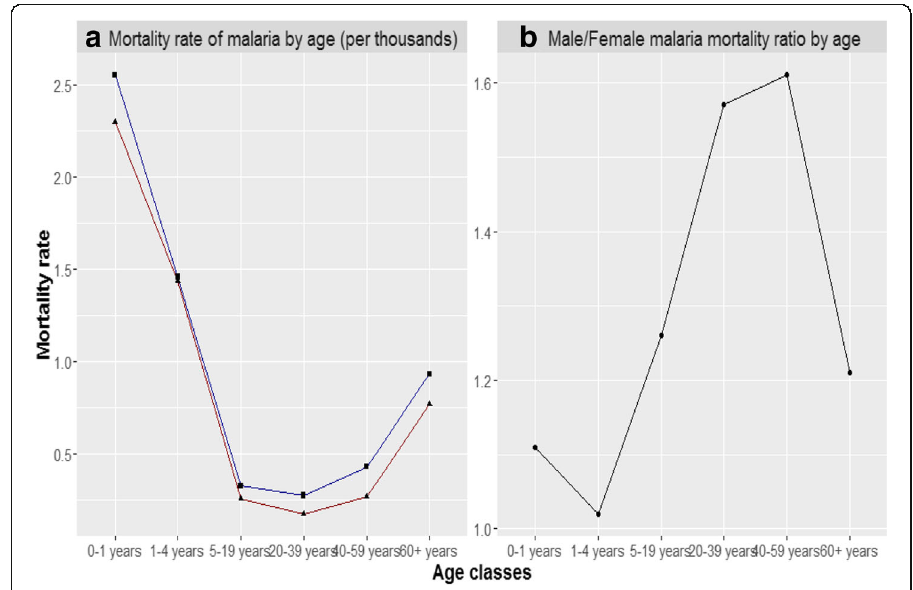
Fig. 2 Evolution of malaria mortality by age and gender. Note: Panel a shows the evolution of malaria mortality by age and gender. The blue line indicates the mortality rate for males, the red line indicates the mortality rates for females. Panel b shows the Male/Female mortality ratio by age. Source : Authors ’ calculation on Ministero Agricoltura, Industria e Commercio (1890)